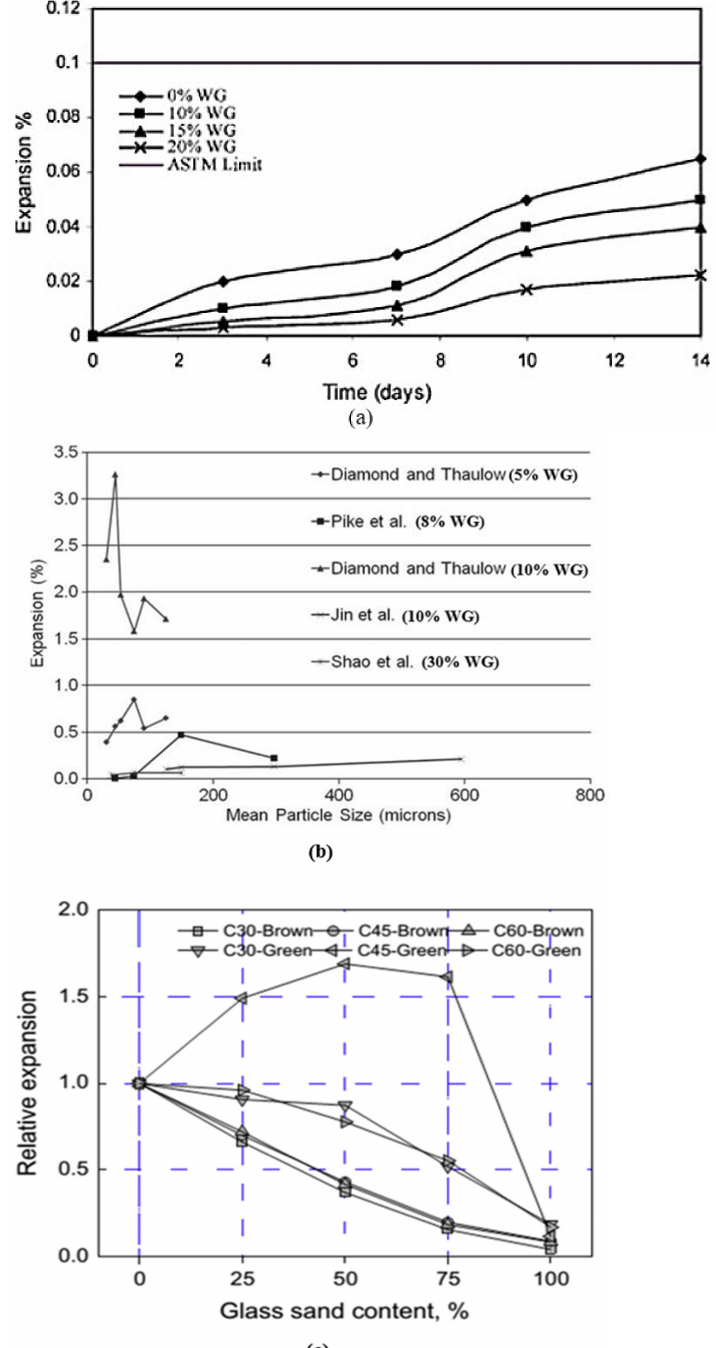
Figure 15. ASR expansion of WG concrete. ( a ) Expansion of mortar bars with WG (particle size: 0.6–2.36 mm) [51]; ( b ) variation in the ASR expansion with mean WG powder particle size [38]; ( c ) relative ASR expansion with varying glass content, color, and concrete grades